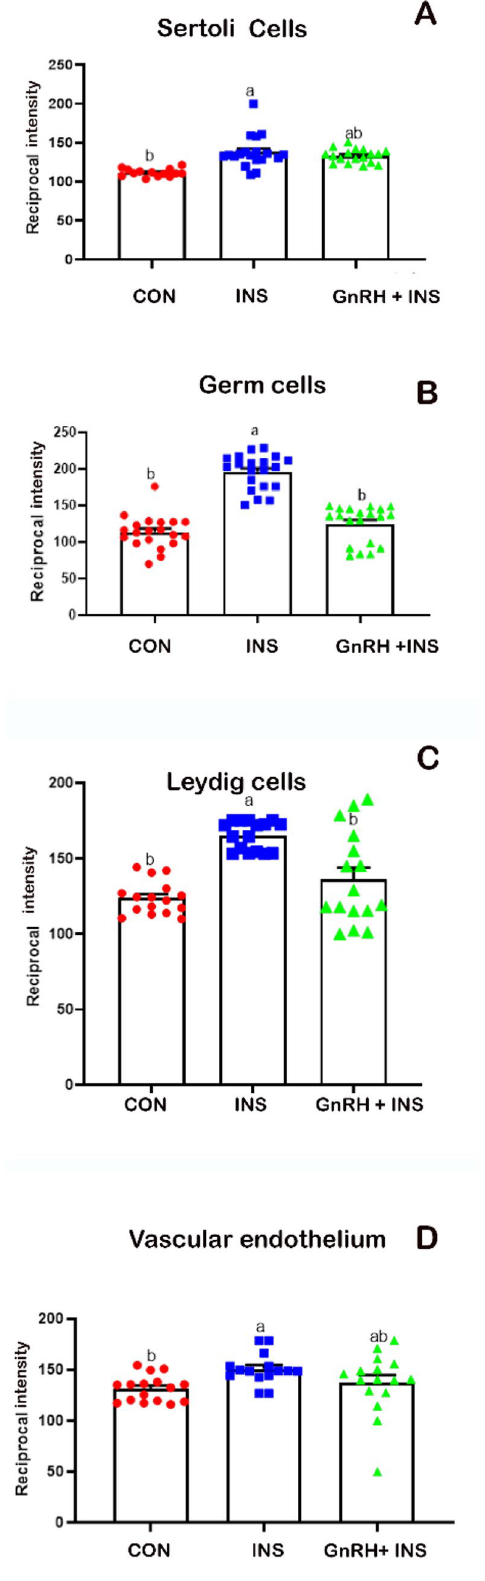
Figure 5. Reciprocal staining intensity of VEGF in ( A ) Sertoli, ( B ) germ, ( C ) Leydig cells and ( D ) vascular endothelium of buck’s testis. Different letters indicate significant differences between the groups ( p < 0.05). Results are presented as mean ±